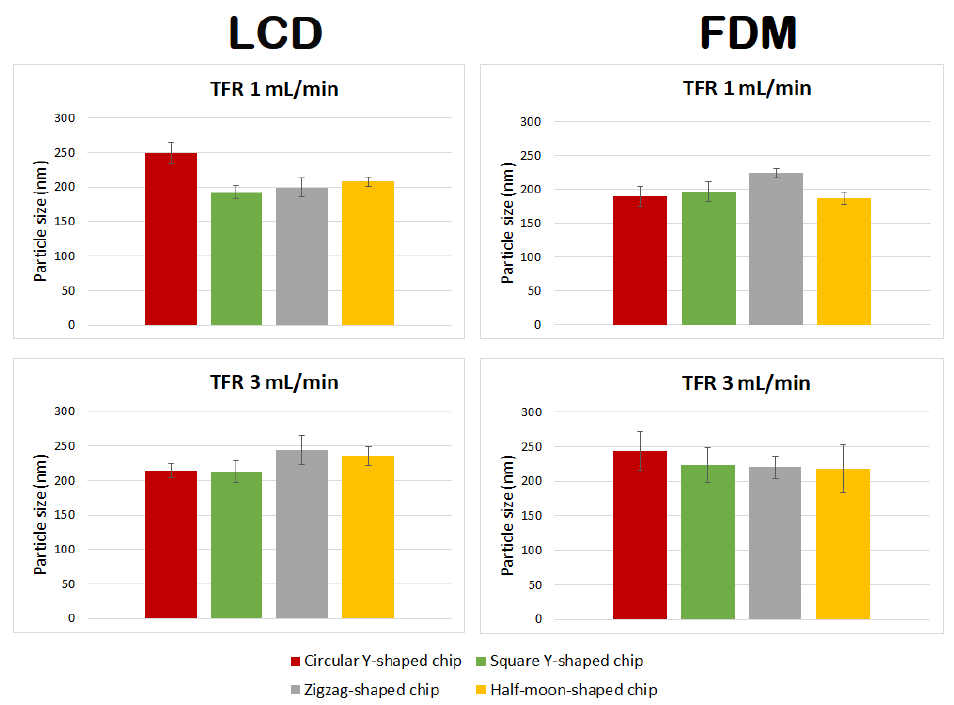
Figure 10. Comparison of particle size of curcumin-loaded liposomes prepared using circular Y-shaped, square Y-shaped, zigzag-shaped, and half-moon-shaped chips at TFRs of 1 and 3 mL min − 1 . Table 3. Values tabulated are two-tailed p -values calculated from mean sizes of curcumal liposomes